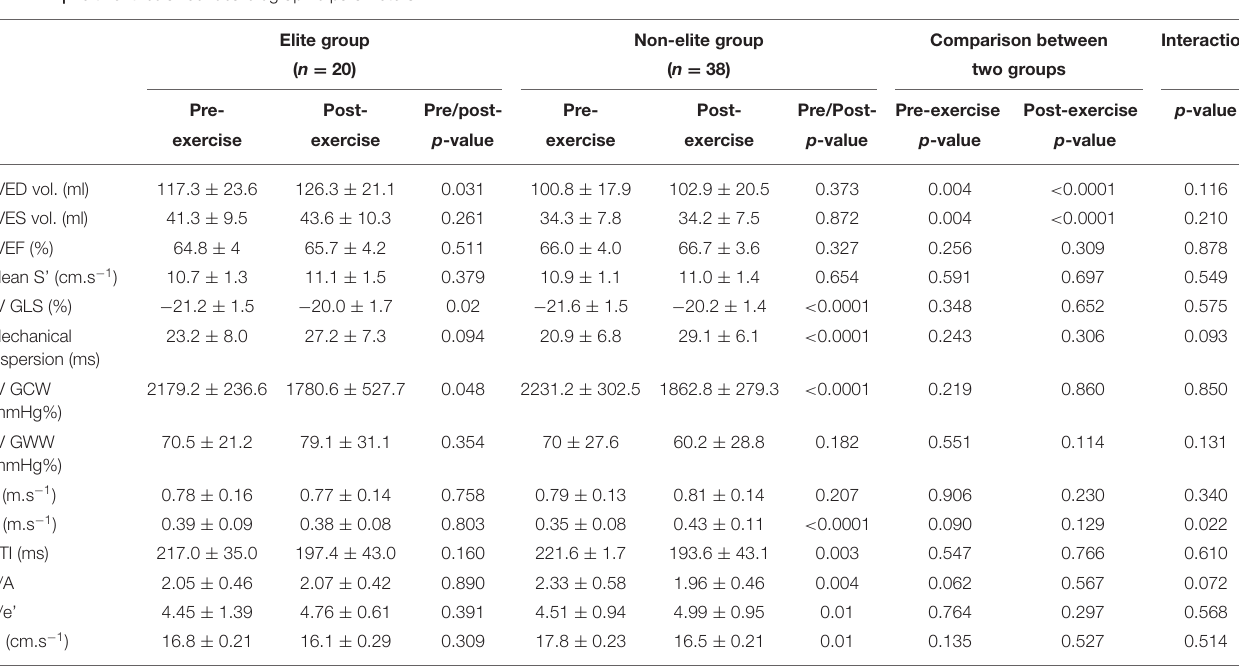
TABLE 2 | Left ventricular echocardiographic parameters. Elite group Non-elite group Comparison between Interaction ( n = 20) ( n = 38) two groups Pre- Post- Pre/post- Pre- Post- Pre/Post- Pre-exercise Post-exercise p -value exercise exercise p -value exercise